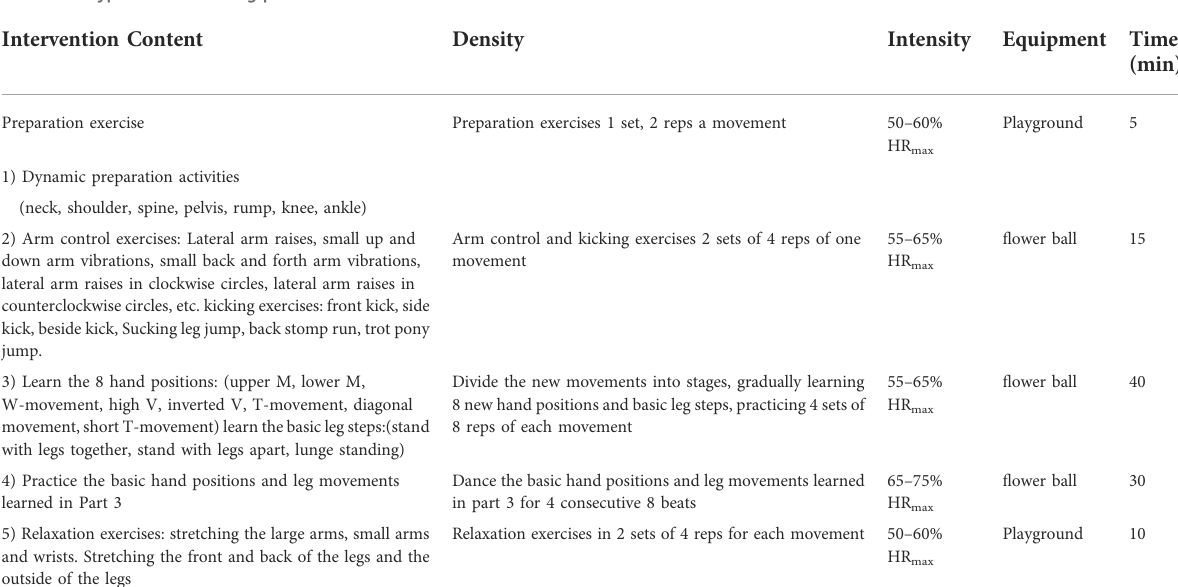
TABLE 1 A typical cheerleading practice schedule. Intervention Content Density Intensity